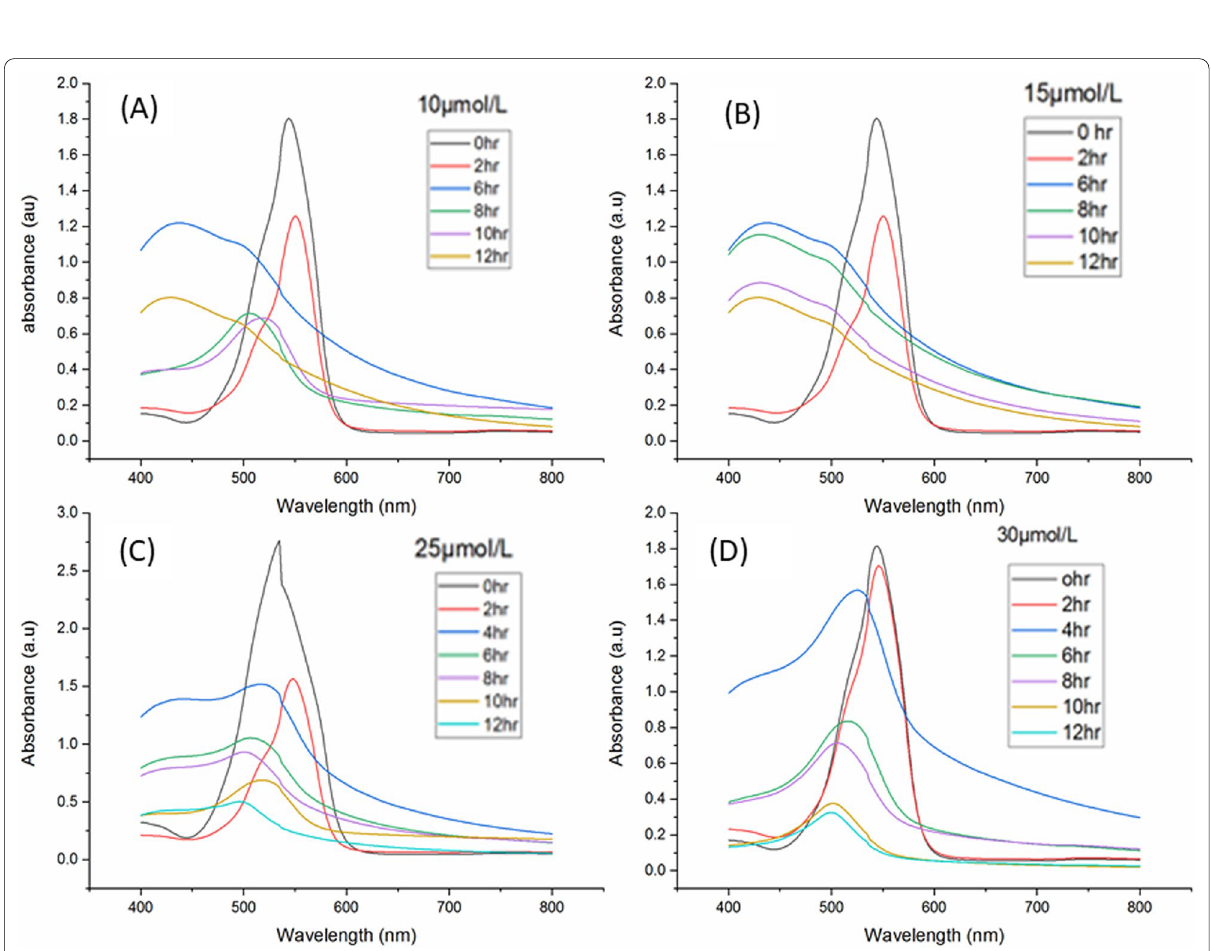
Fig. 7 Time dependence of optical absorption spectra of RhB of different concentrations- 10 µmol/L, 15 µmol/L, 20 µmol/L, 25 µmol/L and 30 µmol/L subjected to photo-catalytic degradation under direct sunlight by sample